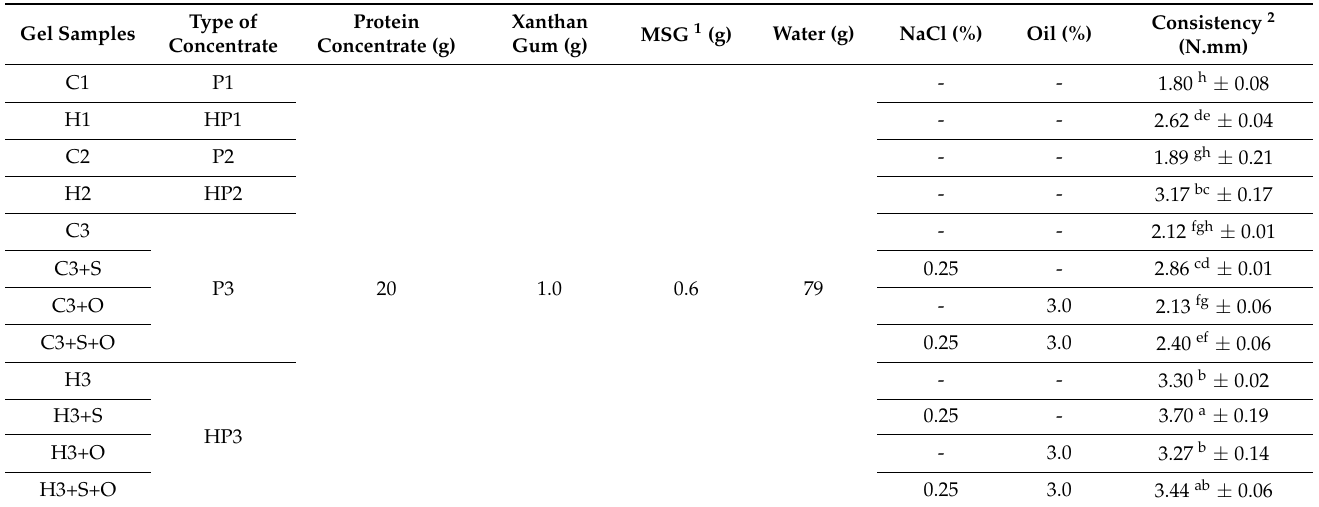
Table 1. Name, composition and consistency (N.mm) of the 12 studied